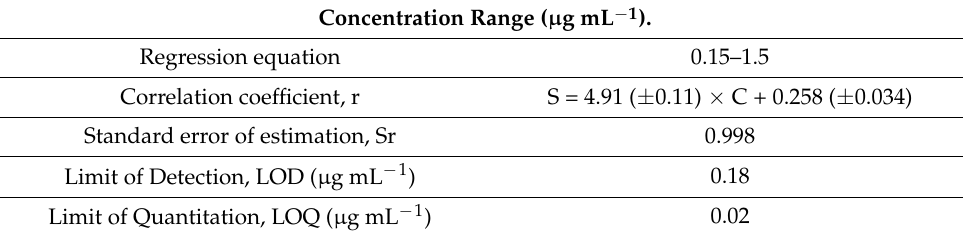
Table 1. Linearity data for the quantitation of octreotide as assessed by the HILIC-FL method. Concentration Range ( µ g mL − 1